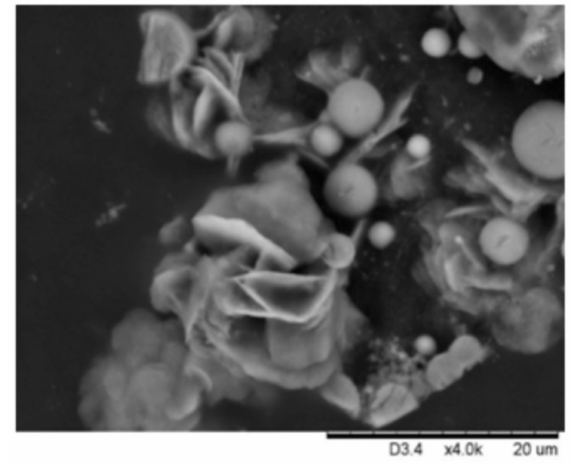
Figure A3. Competition between assembly of nanoshells and sheets when higher amounts of titania and alginate were used.